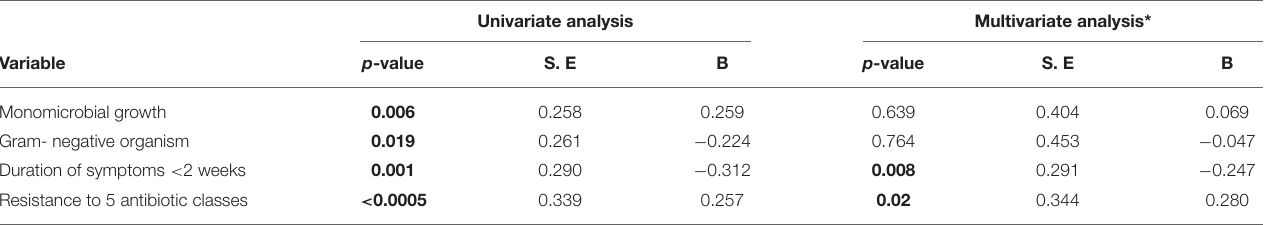
TABLE 8 | Factors associated with duration of hospital stay: linear regression analysis. Univariate analysis Multivariate